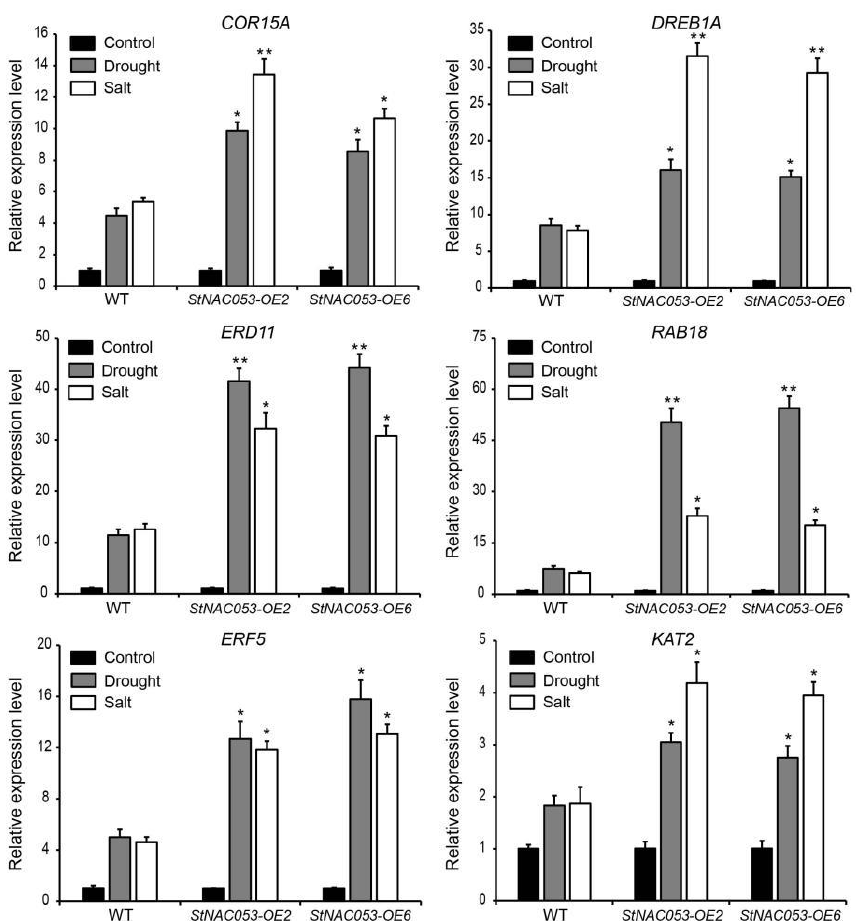
Figure 11. Expression of stress-responsive genes in StNAC053 overexpressing and wild-type Ara- bidopsis after drought or salt stress treatments. WT, wild-type. The data were means ± SD from three independent replications. * p < 0.05, ** p < 0.01.